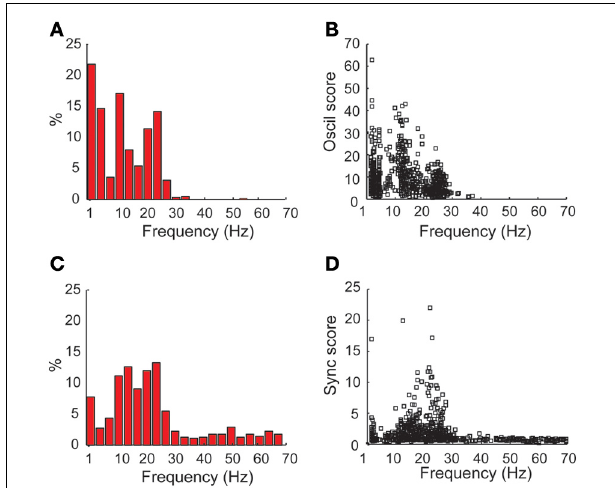
FIGURE 7 | Dominance of coherence at the beta frequency range vs. tremor frequency and beta oscillations in the power spectrums in the STN DLOR. (A) Frequency distribution of the frequencies with maximal power in the power spectrums of STN DLOR recording sites. (B) Scatter plot of oscillations ( oscil ) scores vs. the frequency with maximal power. (C,D) show the frequency distribution and scatter plot, respectively, for the coherence, same conventions as in (A,B) . N = 1230 single DLOR sites and 615 DLOR-DLOR